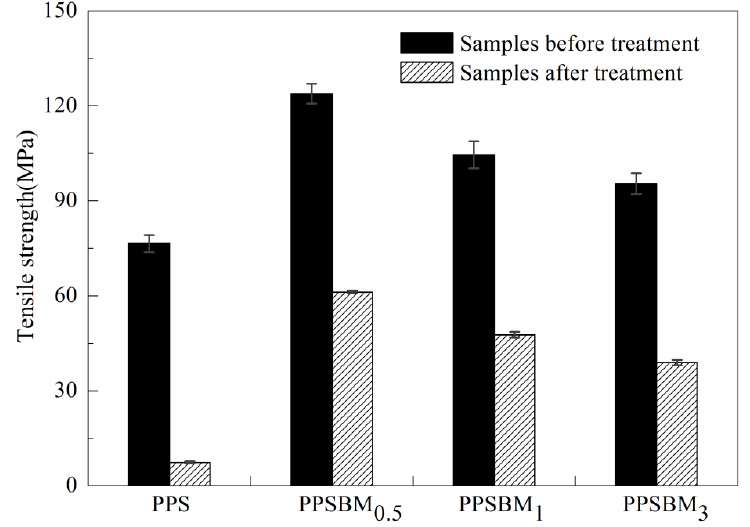
Figure 5. Tensile strength changes of PPS and PPSBM x composites after oxidation treatment.